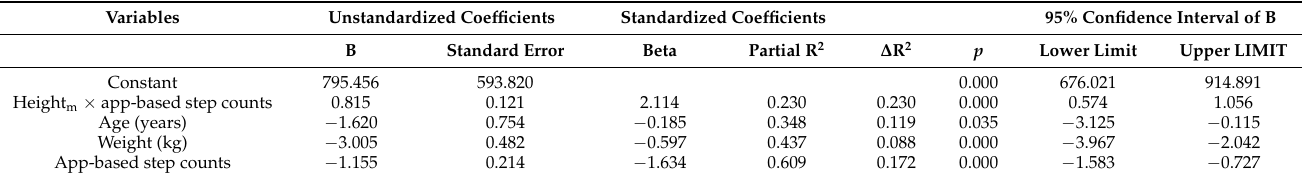
Table 4. Predictive model for six-minute walk